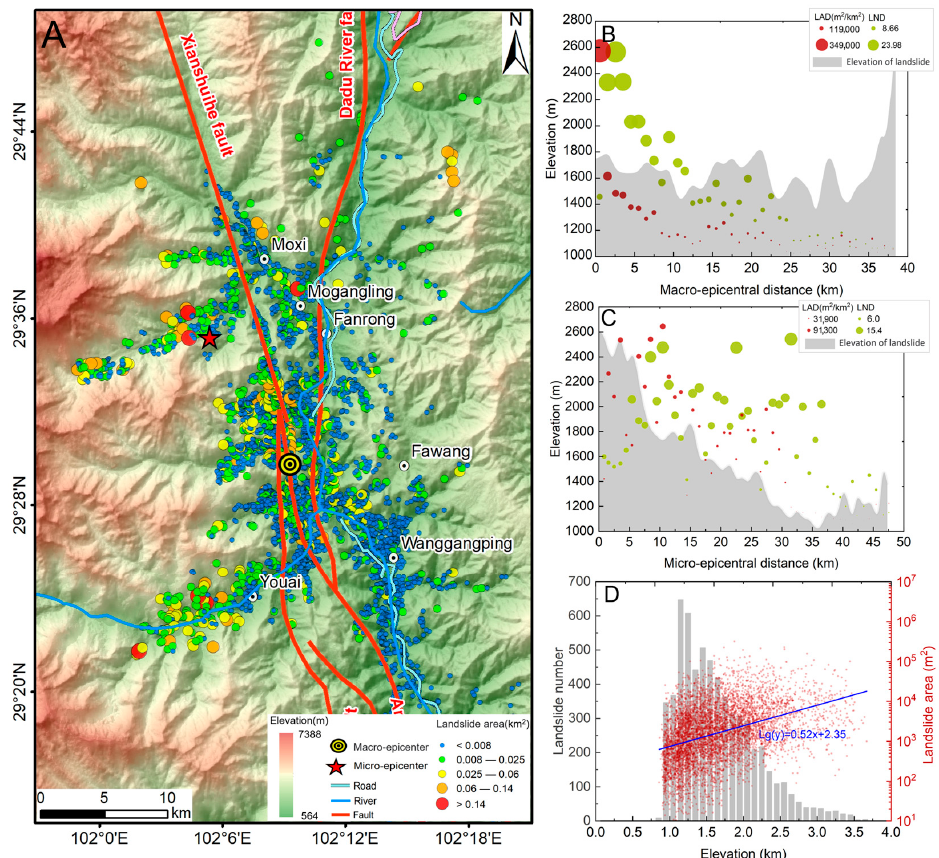
Figure 10. ( A ) coseismic landslide distribution with elevation; ( B , C ) elevation of landslide with macro- and micro-epicentral distance; ( D ) individual landslide distribution with elevation.